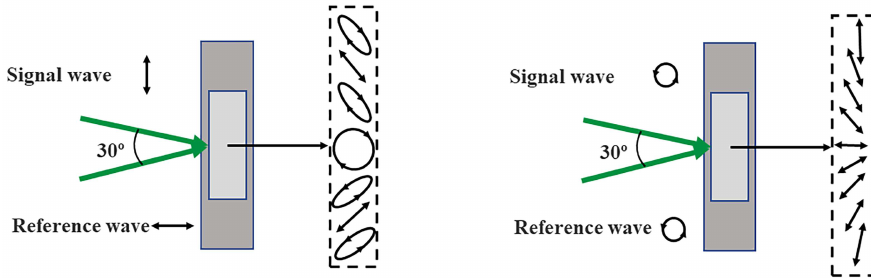
Figure 2. Interference field with the periodic change of the polarization states caused by two orthogonally linear polarized waves or two orthogonally circularly polarized